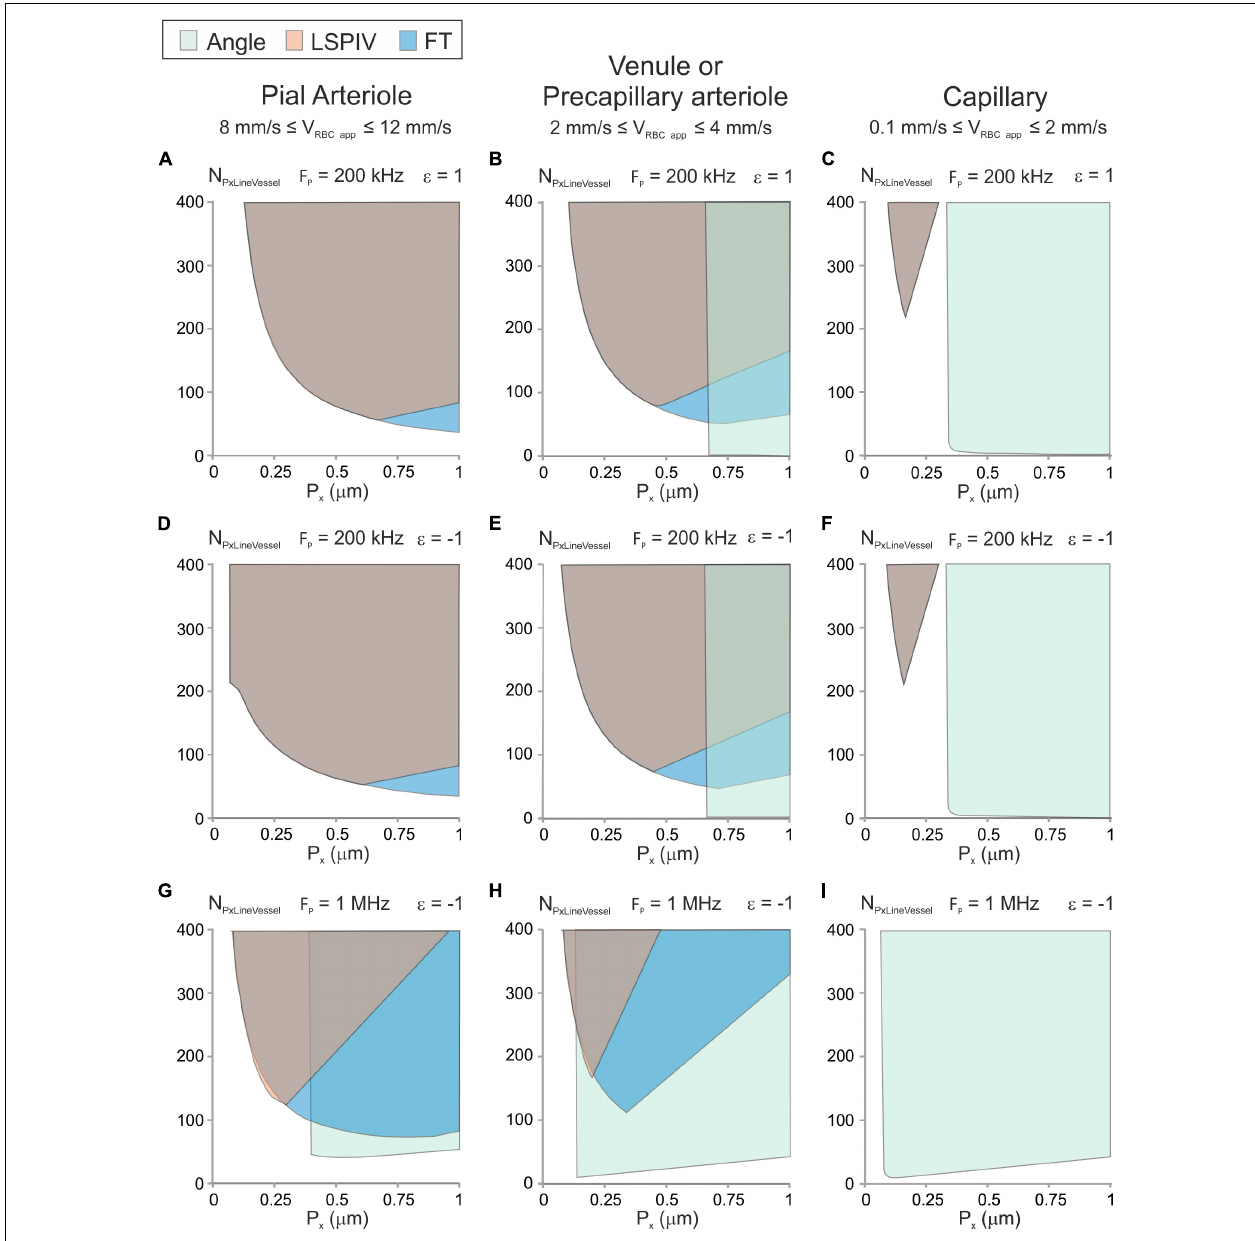
FIGURE 4 | Parameter space and image-analysis algorithms that can be used with typical vessel types. Graphic showing the possible experimental conditions (P x , N PxLineVessel ) and image-analysis algorithms for typical vessels calculated from Equations (12), (14), (15), (21)–(24) for an error level of 10% with D RBC = 6 µ m, H t = 0.35 and γ Vessel = 0.5. (A–C) Anterograde scanning and F p = 200 kHz. (D–F) Retrograde scanning and F p = 200 kHz. (G–I) Retrograde scanning and F p = 1 MHz. The parameter space satisfying the conditions to get accurate velocity measurement is colored in green for the “Angle” algorithm, in orange for the LSPIV algorithm and in blue for the Fourier Transform algorithm. For some combinations of scanning parameters, colors are overlaid. (A,D,G) Example of a parenchymal arteriole with 8 mm/s ≤ V RBC app ≤ 12 mm/s. (B,E,H) Example of a venule or a precapillary arteriole with 2 mm/s ≤ V RBC app ≤ 4 mm/s. (C,F,I) Example of a capillary with 0.1 mm/s ≤ V RBC app ≤ 1 mm/s.